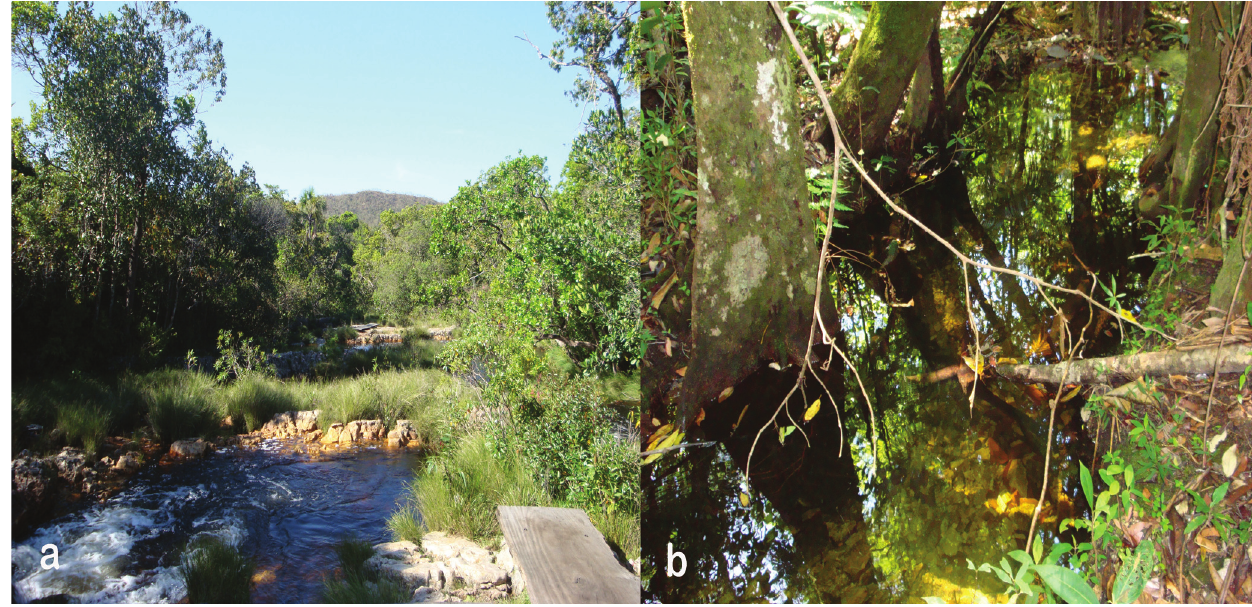
Fig. 4. ( a ) Rio dos Couros downstream from the Cachoeira São Bento, type-locality of Astyanax courensis , new species; ( b ) small stream tributary of rio dos Couros at Parque Portal da Chapada, locality of collection of Astyanax goyanensis .